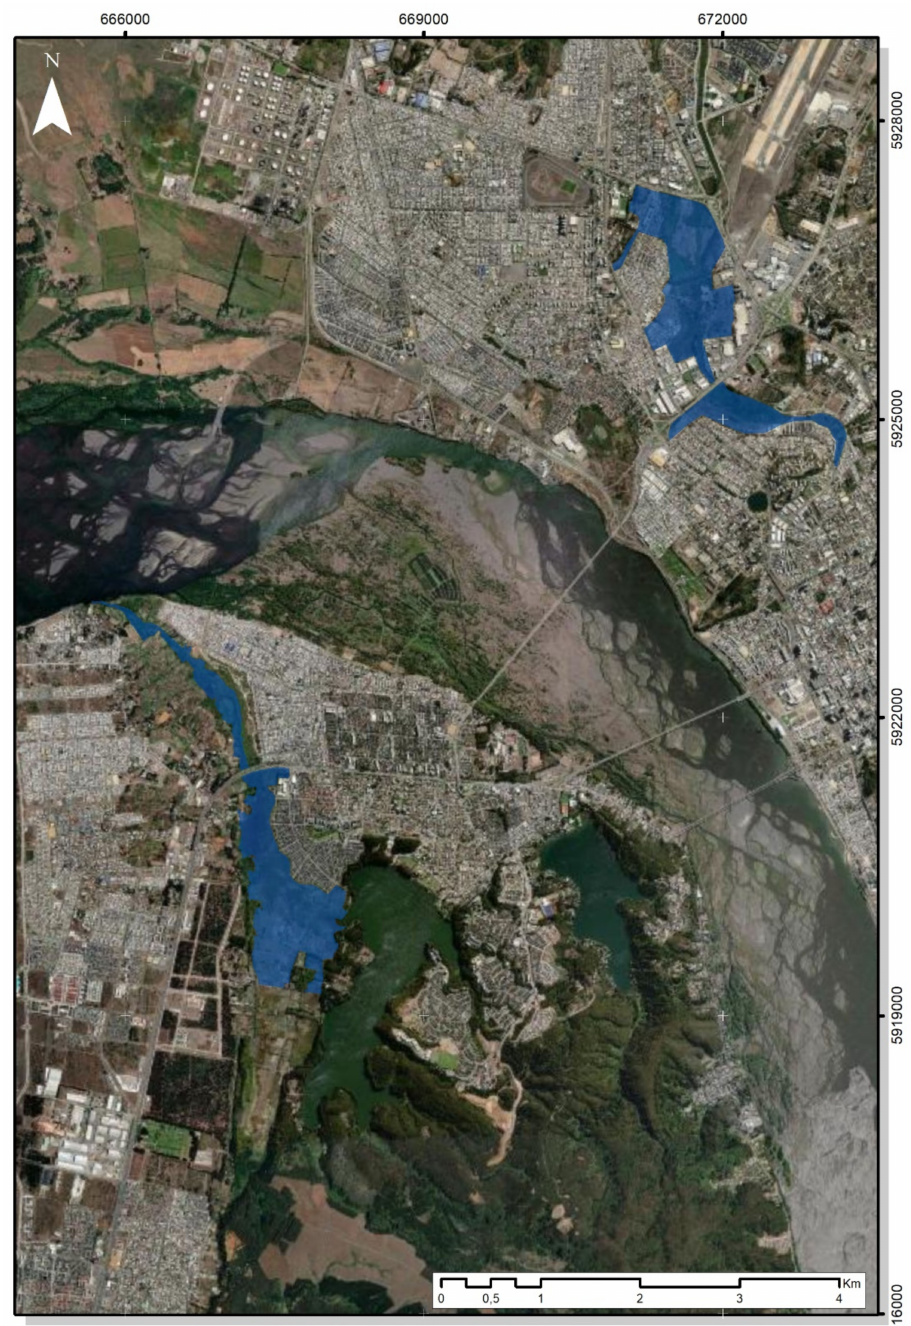
Figure 2. Paicav í Wetland (north) and Los Batros Wetland (south)